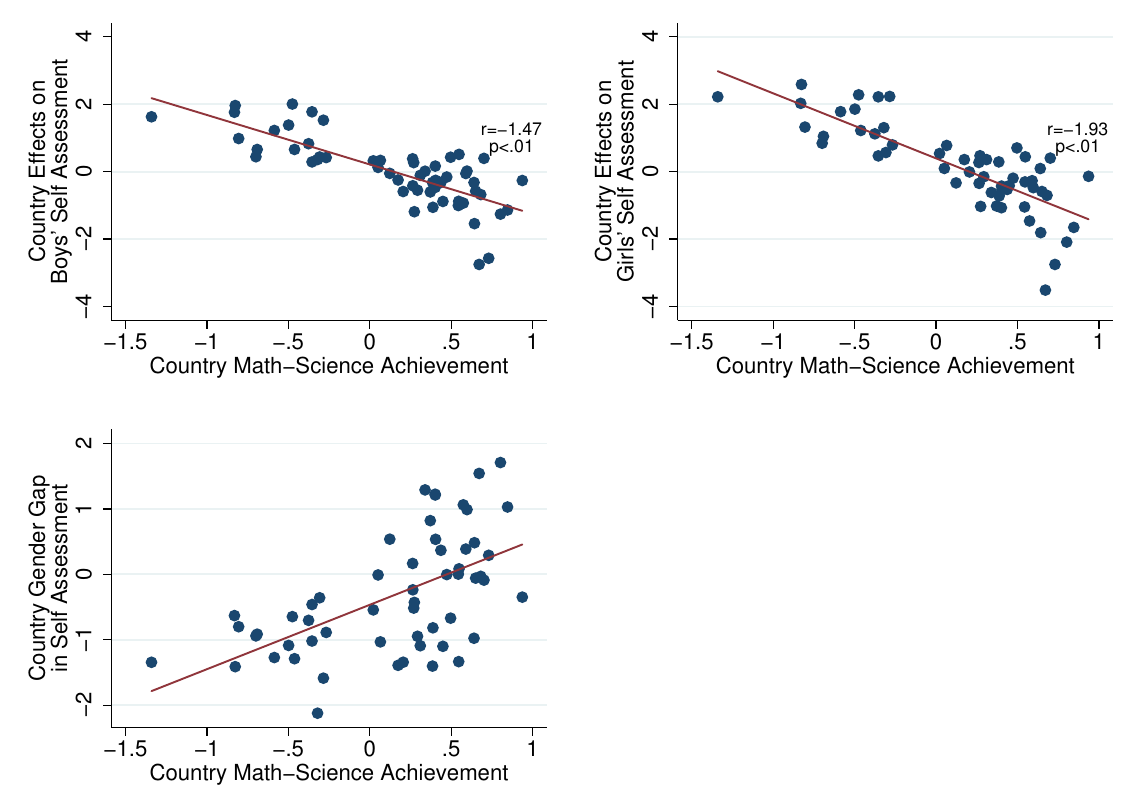
Figure 3: Country self-assessment effect versus country math and science